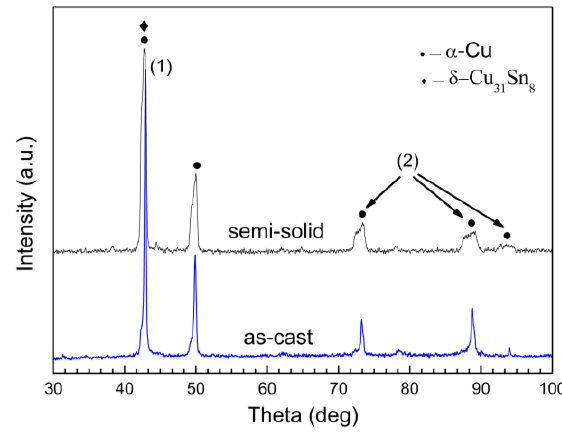
Figure 5. XRD spectrum of ZCuSn10P1 alloy.